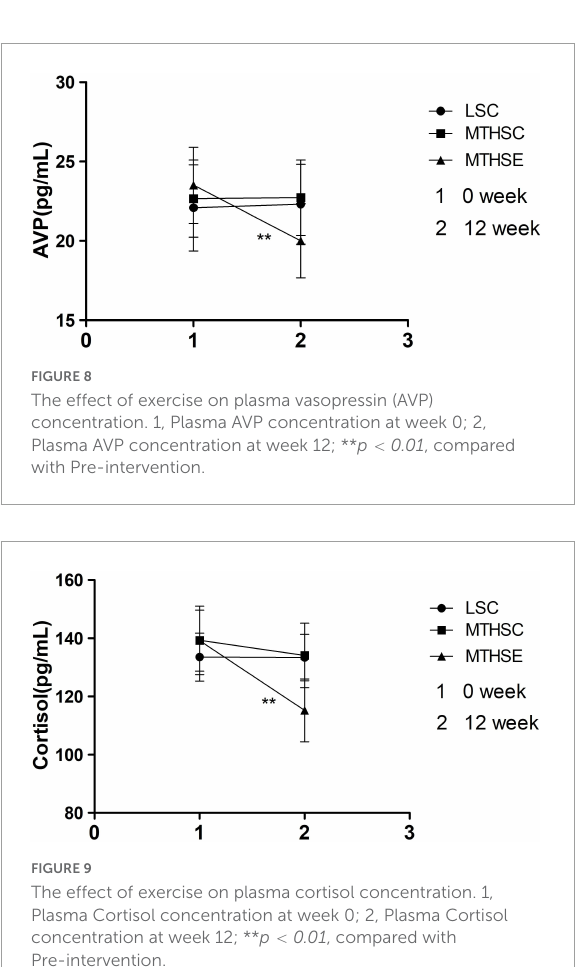
25.41) and the LSC group ( p < 0.01 , 95% CI: 11.69,